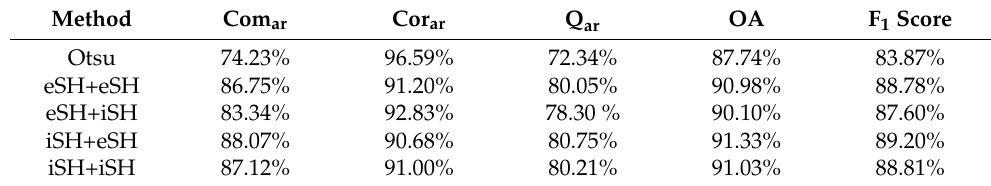
Table 8. Quantitative evaluation results of different vegetation detection methods.